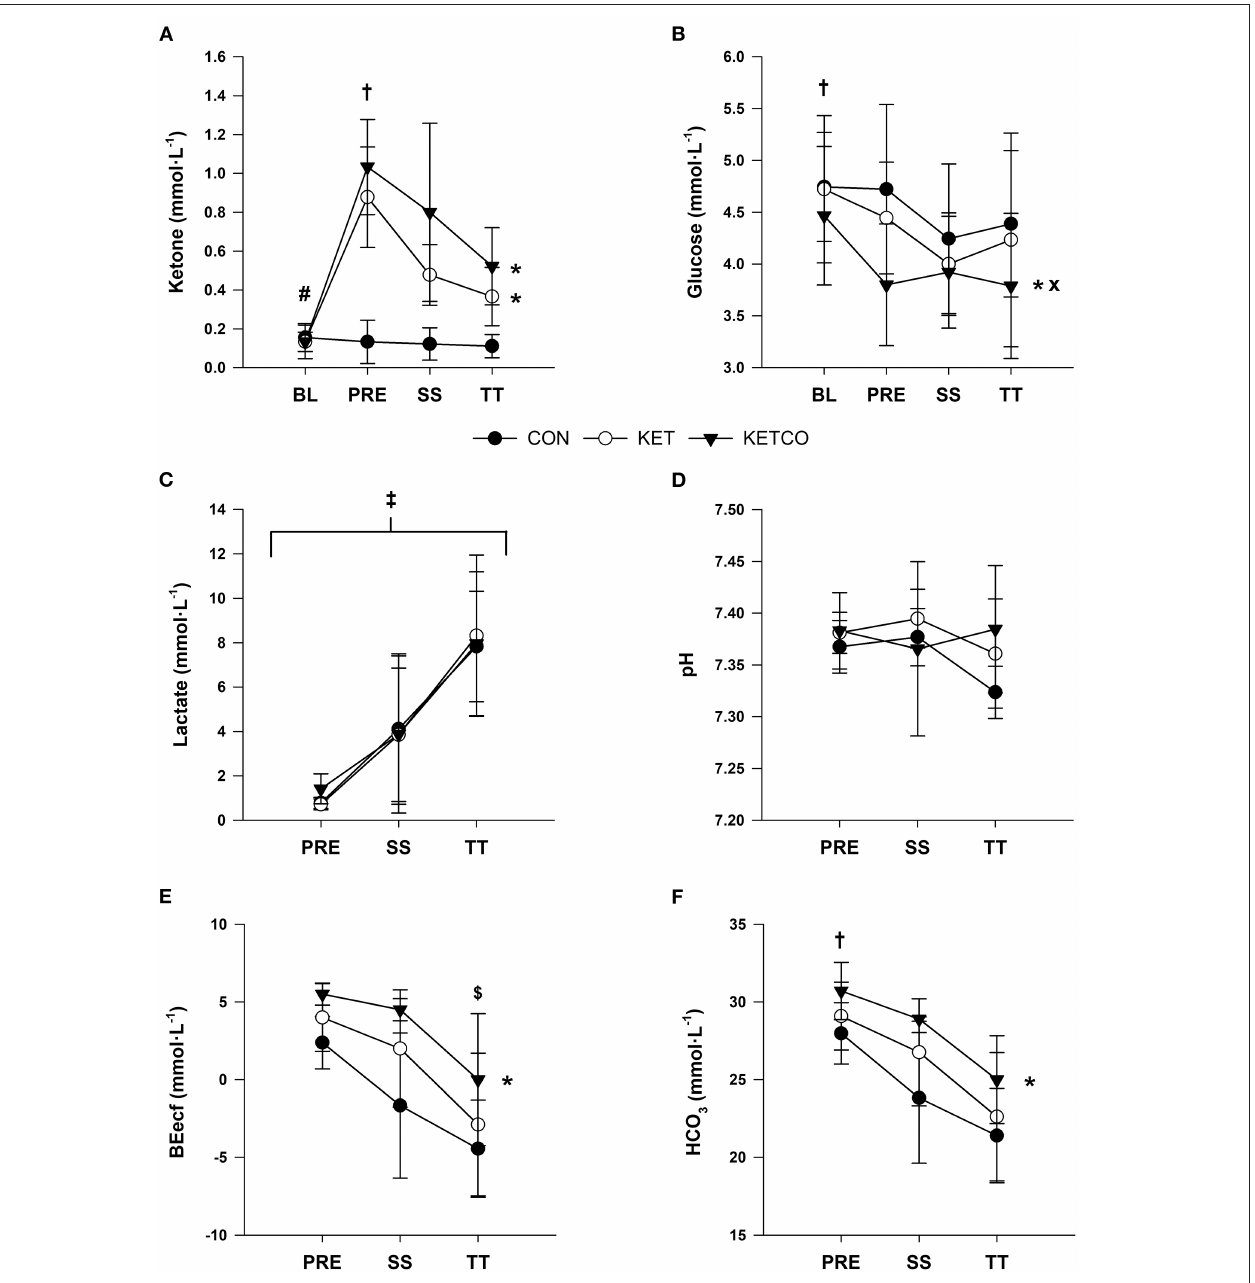
FIGURE 4 | (A) Mean ketone ( β -OHB) concentrations, (B) mean glucose concentrations, (C) mean lactate, (D) mean pH, (E) mean base excess (BEecf), and (F) mean bicarbonate (HCO 3 ) during each experimental condition at BL, PRE, SS, and TT. *Significantly different from CON, # significantly different from PRE, SS, and TT, † significantly different from SS and TT, × significantly different from KET, ‡ significantly different at PRE, SS, and TT, $ significantly different from